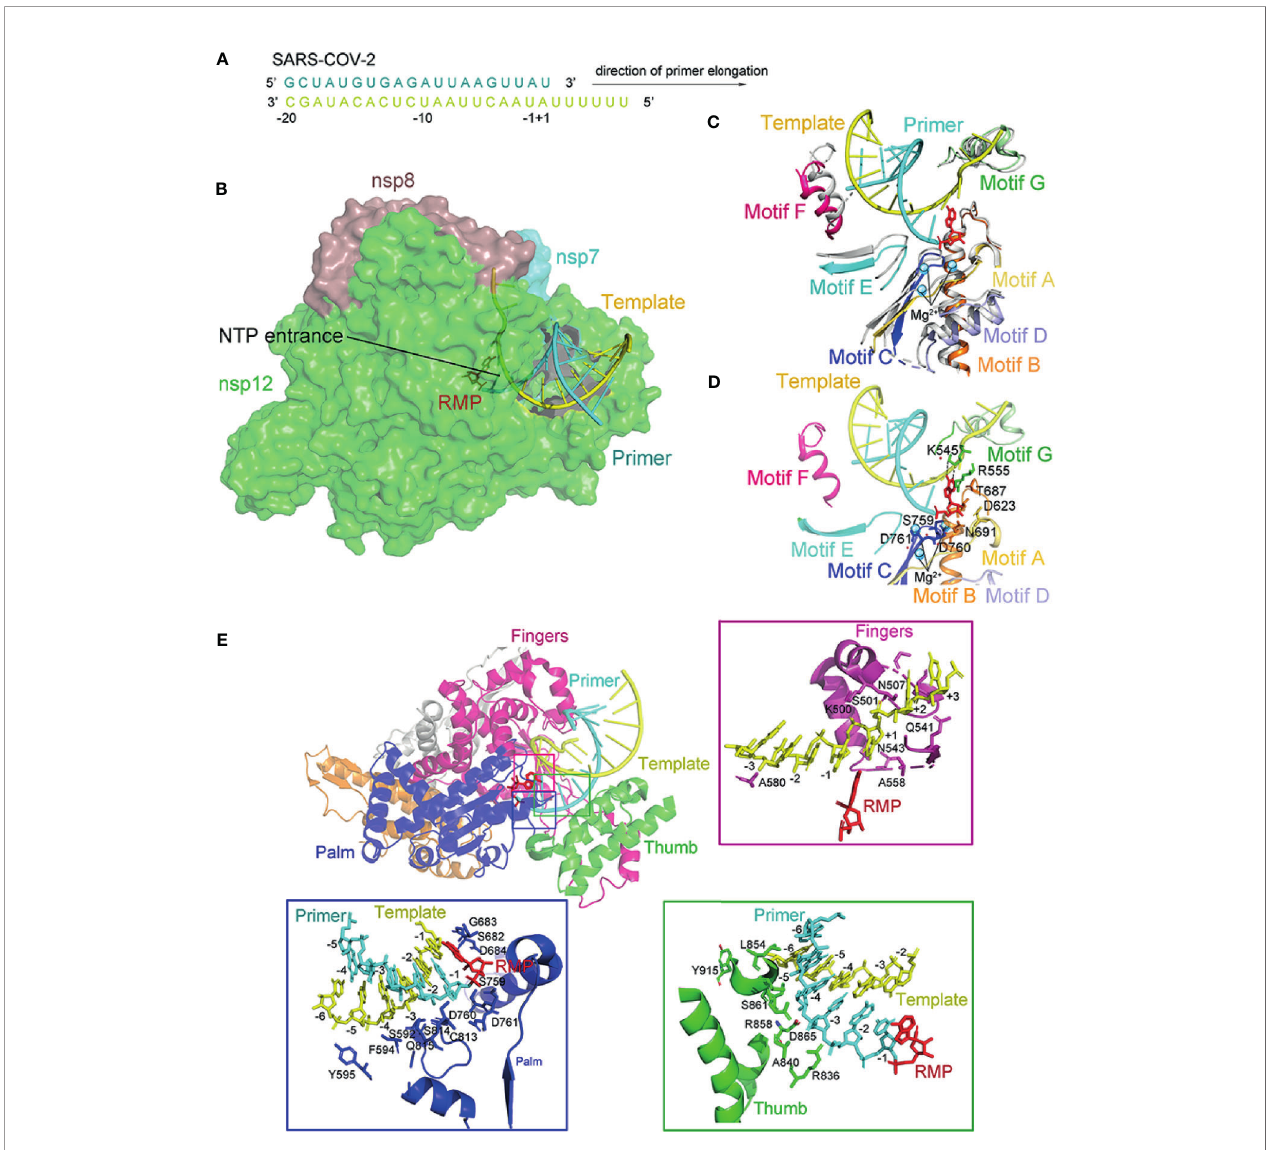
FIGURE 11 | The structure of the template-RTP RdRp complex. (A) The sequence of the RNA duplex with a 5 ′ U10 overhang as a template for extending primer and assembling the RdRp-RNA complex. (B) Cryo-EM Structure of the Remdesivir and RNA bound RdRp complex. Template and Primer are shown as yellow and cyan. (C) The conserved RdRp motifs (A to G) of the RNA-bound complex overlap with the apo structure, and color in gray, with a close view at the active site. Motifs (A to G) are shown in light orange, orange, blue, light blue, aquamarine, warm pink, and pale green, respectively. (D) A close view of the RdRp active site, showing the covalently bound RMP, magnesium ions, and pyrophosphate. Key residues and bases interacting with Remdesivir are shown. (E) Remdesivir-bound RdRp complex and protein-RNA interactions in the RNA. All structures are drawn by